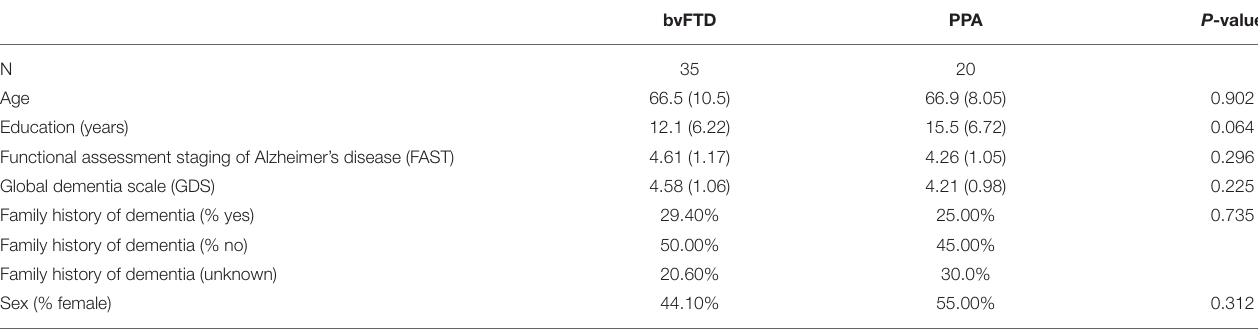
TABLE 1 | Demographic and clinical data of the sample according to the diagnostic